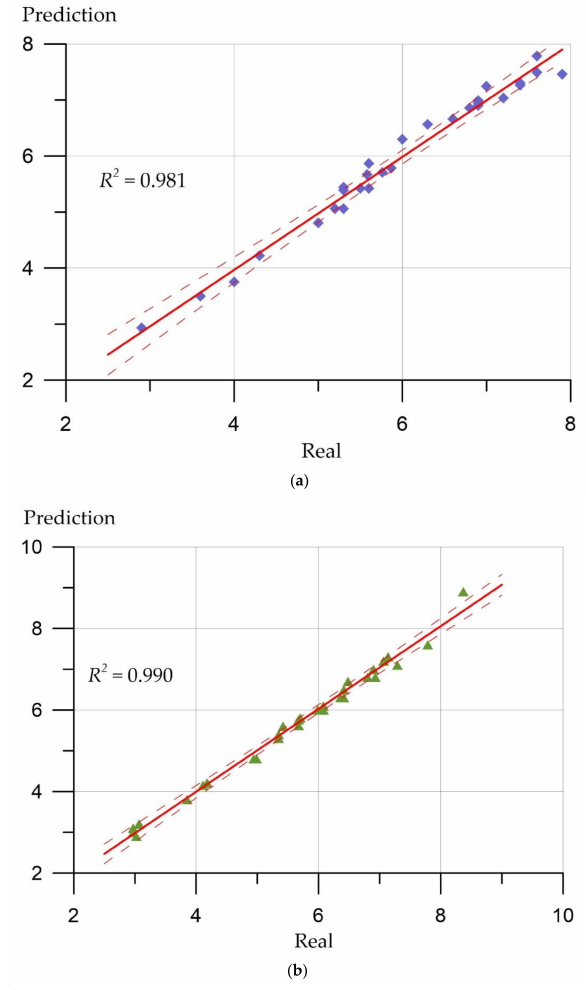
Figure 10. Relationship between real values of axial tensile strength (MPa) and calculated values: ( a ) Deep neural network; ( b ) ensemble of regression